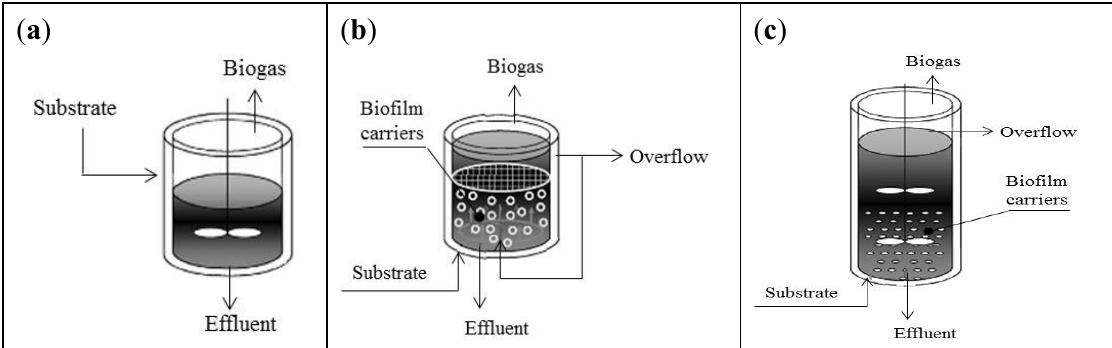
Figure 2. Reactor configuration, adapted from Schmidt et al. [108]. ( a ) Continuous Stirred Tank Reactor (CSTR). ( b ) Fixed Bed Reactor (FBR). ( c ) Anaerobic Sequencing Batch Reactor